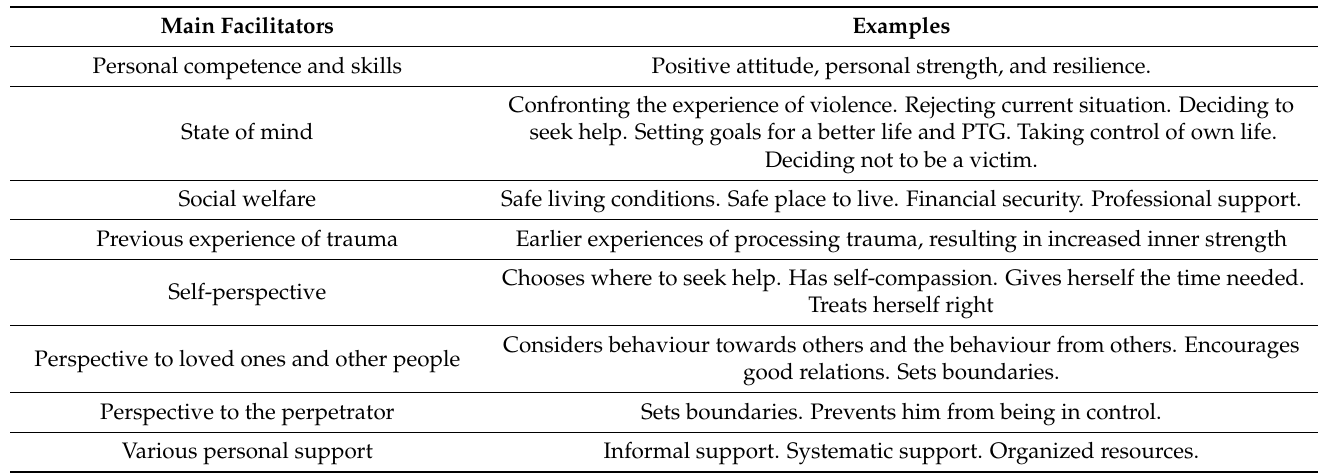
Table 9. Component 6: Overview of the main facilitators on the women’s PTG journey following IPV, according to the